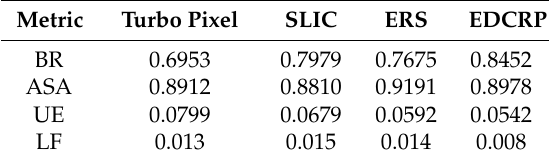
Table 5. The quantitative evaluation of different over-segmentations of QUICKBIRD image.